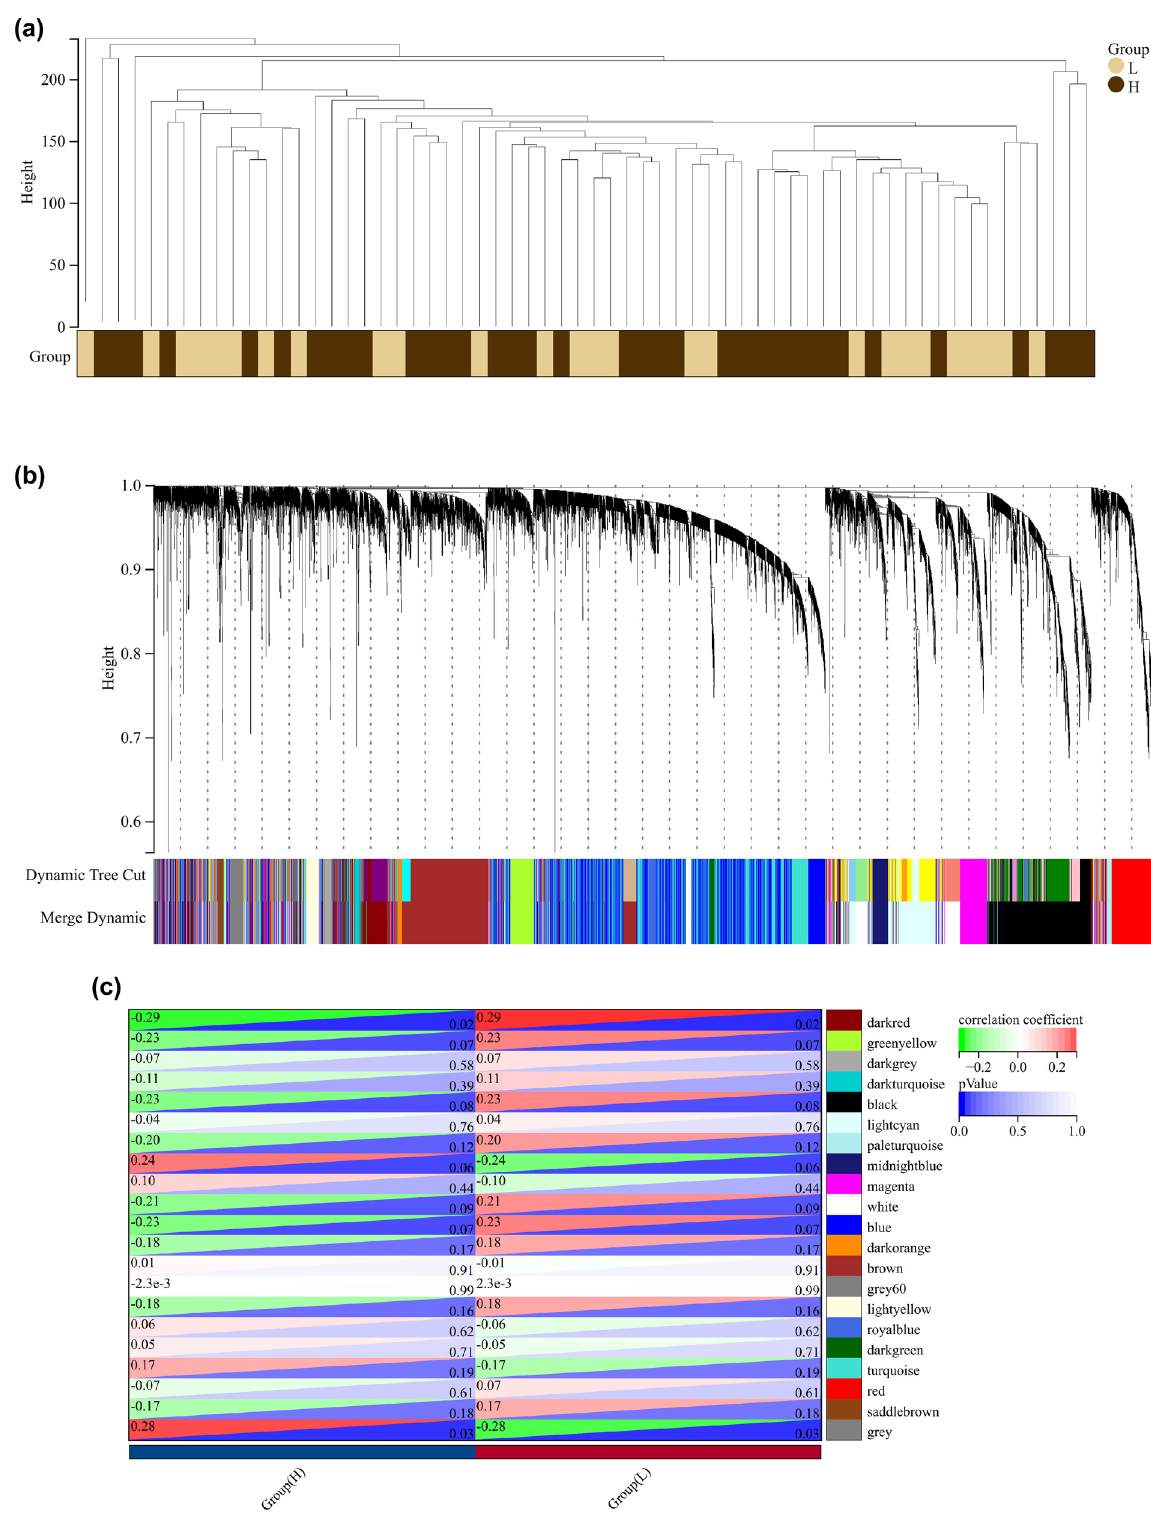
Figure 1: Construction of co - expression modules. ( a ) Clustering dendrogram of 62 samples. ( b ) In the cluster dendrogram of genes in the TCGA database, all genes were clustered in 21 modules. ( c ) Module – trait relationship of two traits and 21